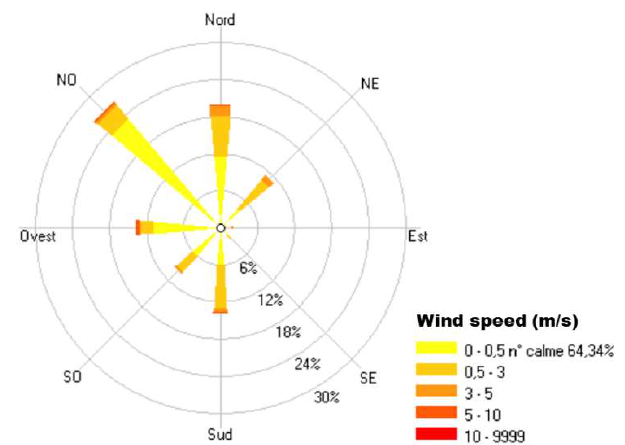
Figure 5. Location of sampling points for ambient air monitoring.